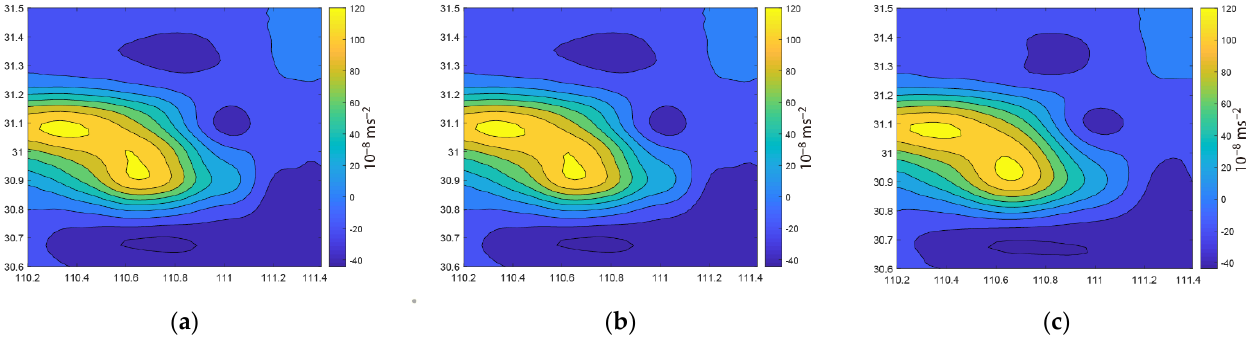
Figure A2. Kriging interpolation of the dynamic changes of the gravity field from October 2002 to October 2003. ( a ) All the stations, ( b ) after removing the stations in Area A, and ( c ) after removing the stations in Area B.